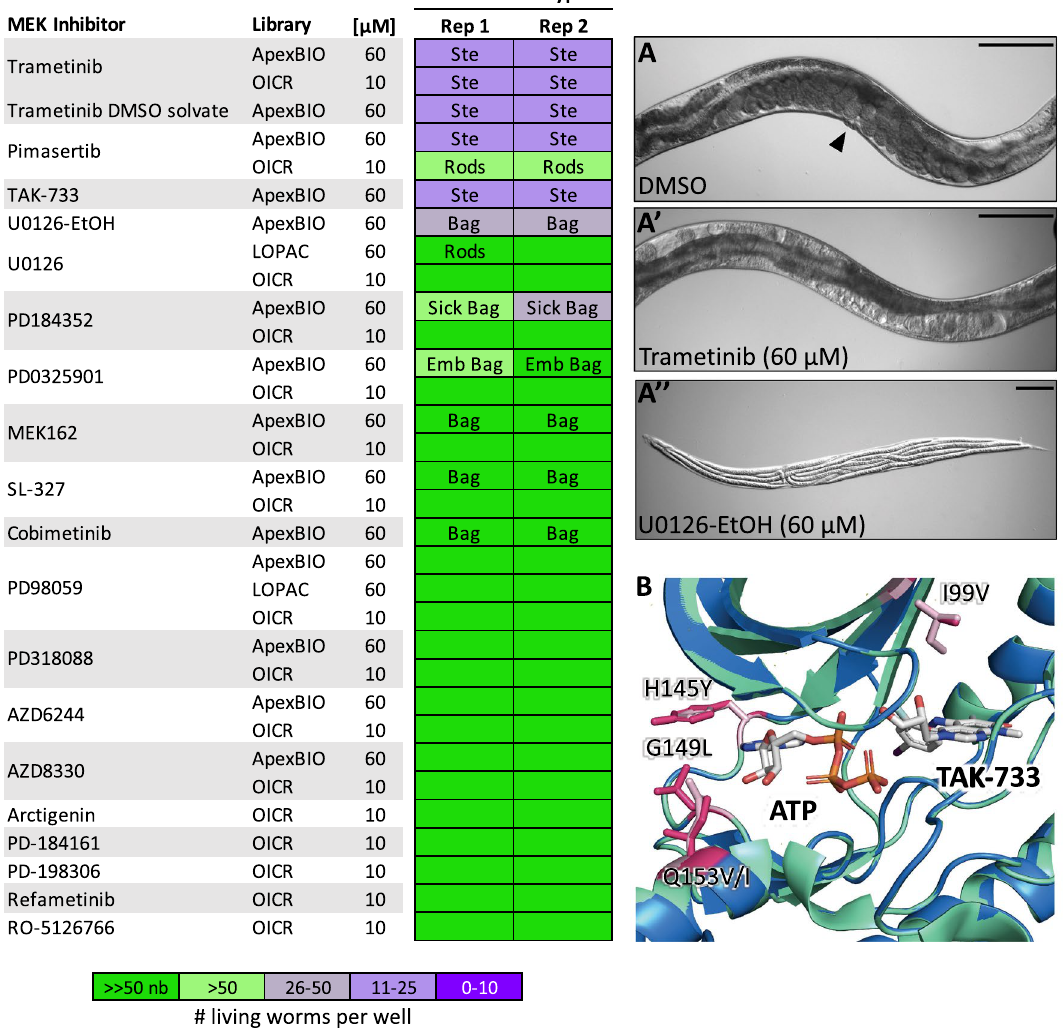
a druggable target.